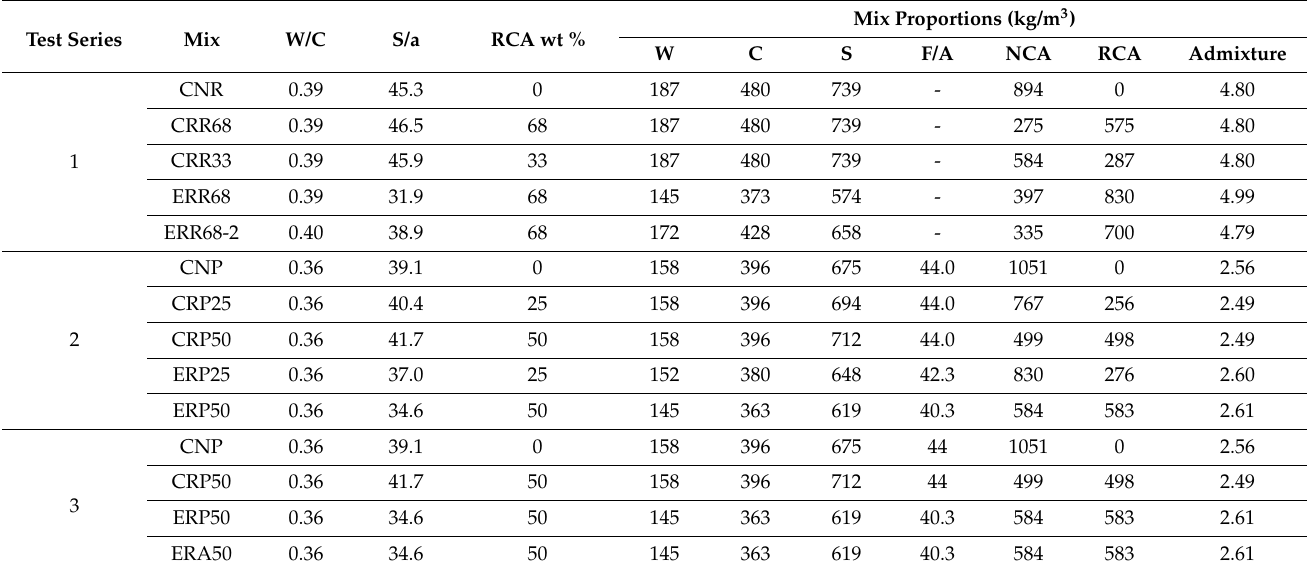
Table 2. Concrete mixture designs and material